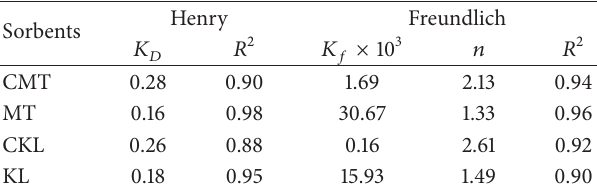
Table 3: Parameters of Henry isotherm and Freundlich isotherm at 298 K.